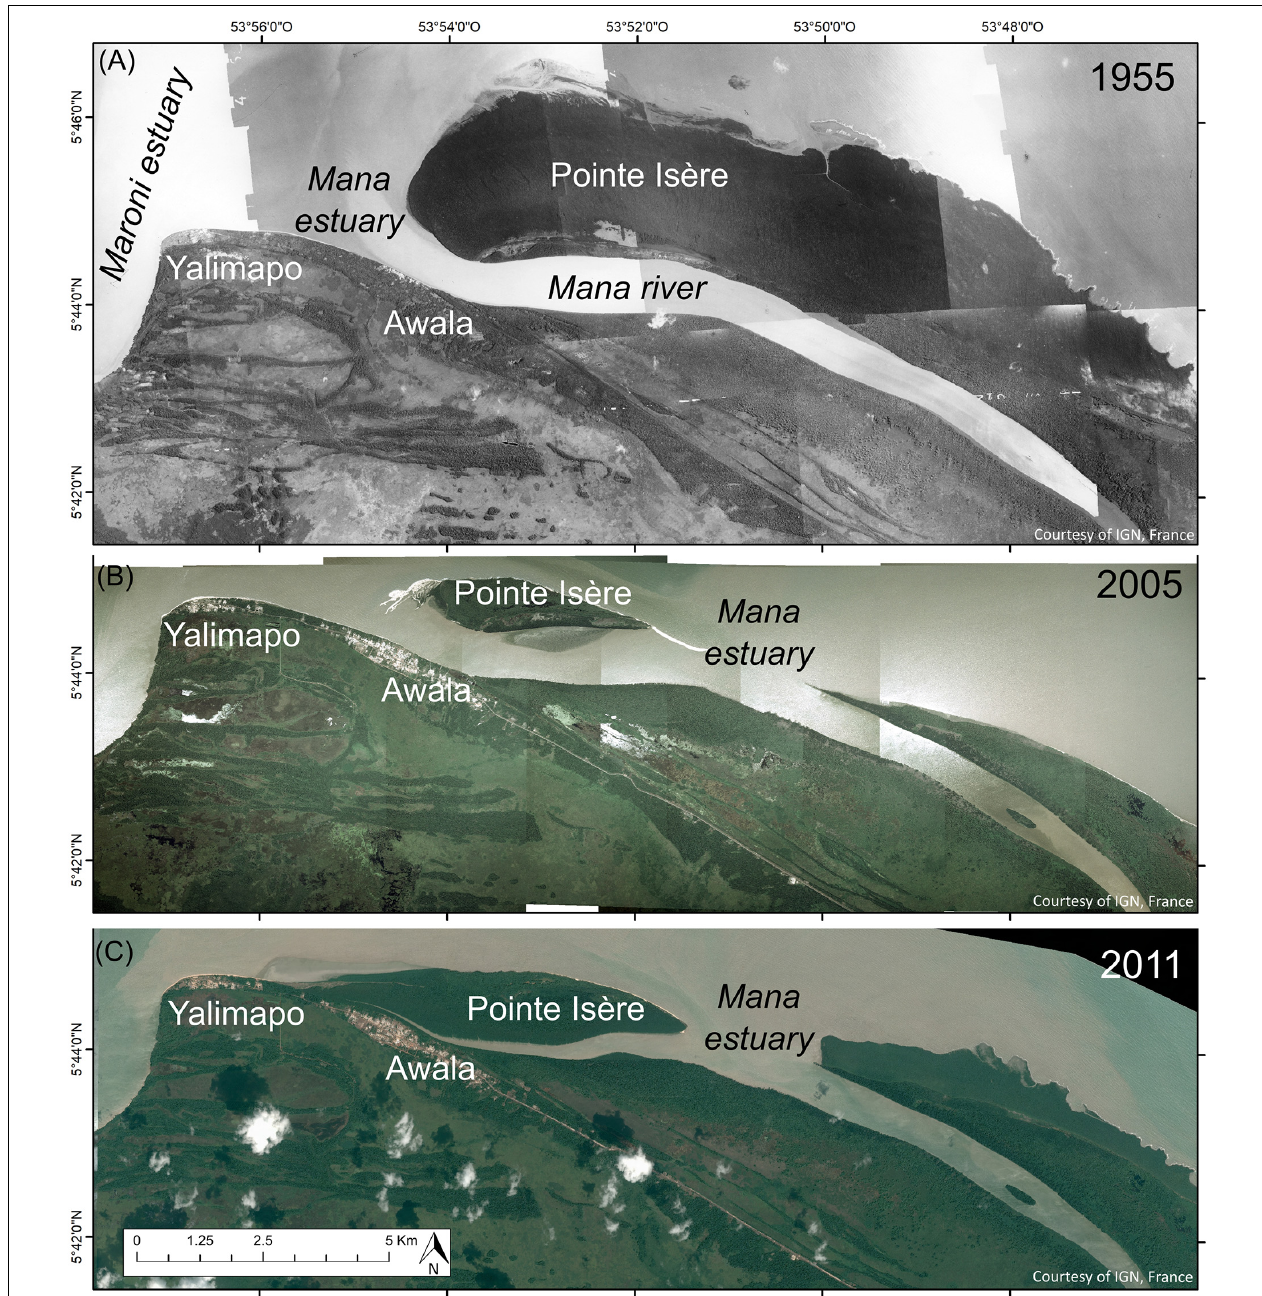
FIGURE 11 | Rapid shoreline changes associated with erosion of much of the mud cape of Pointe Isère between 1955 and 2005 (A,B) and closure of the former mouth of the Mana River between Awala and Yalimapo by shore-welded mangrove-colonized mud that has isolated the beach at Awala from the sea (C)